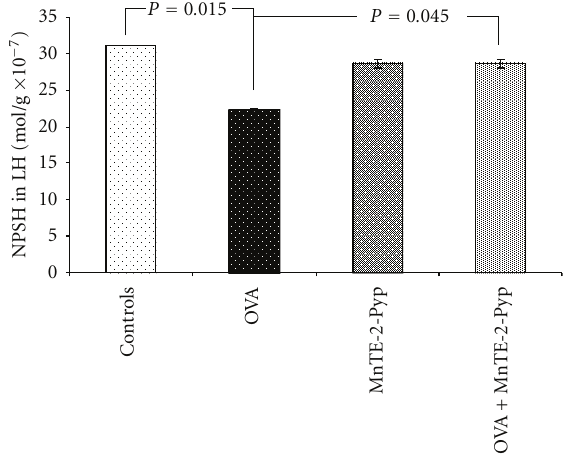
Figure 4: Content of nonprotein sulfhydryl groups in lung homogenate. Each point represents the mean ± SEM for six